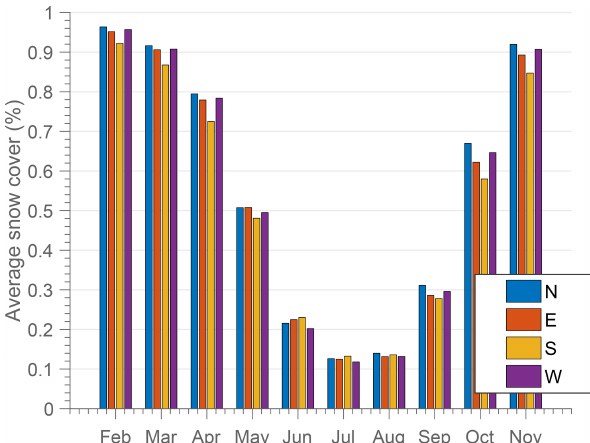
Figure 13. Average elevation distribution of snow cover for 2000–2018. Fractions of area for each elevation band are 23.9% for 0–200ma.s.l., 17.5% for 200–400ma.s.l., 21.7% for 400–600ma.s.l., 18.4% for 600–800ma.s.l., 8.2% for 800– 1000ma.s.l. and 9.9% for elevations over 1000ma.s.l.